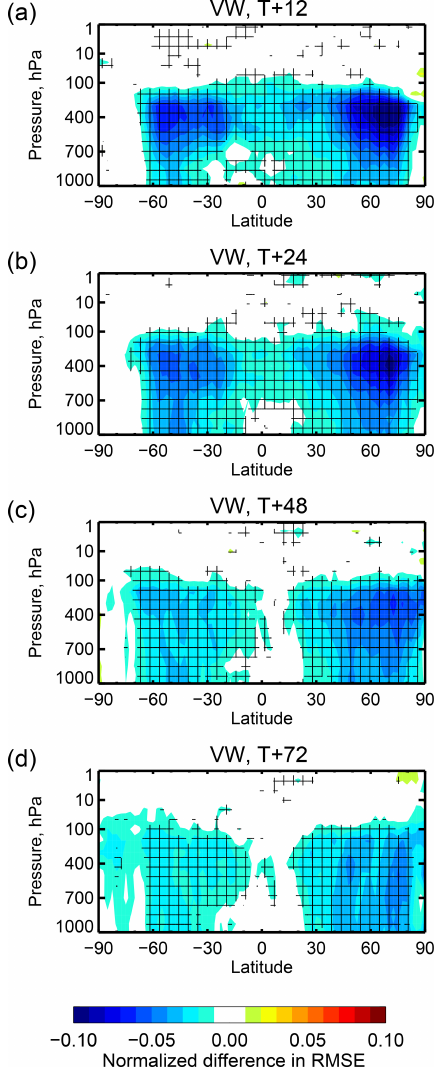
Figure 17. Change in vector wind RMSE due to assimilation of the seven IASI WV channels using the clear-sky approach. Change in RMSE is relative to an experiment in which no observations are assimilated, normalized by the RMSE of the no-observation experi- ment. Cross-hatching indicates 95% statistical significance assum- ing that there are 20 independent hypothesis tests being made in one latitude–pressure diagram.